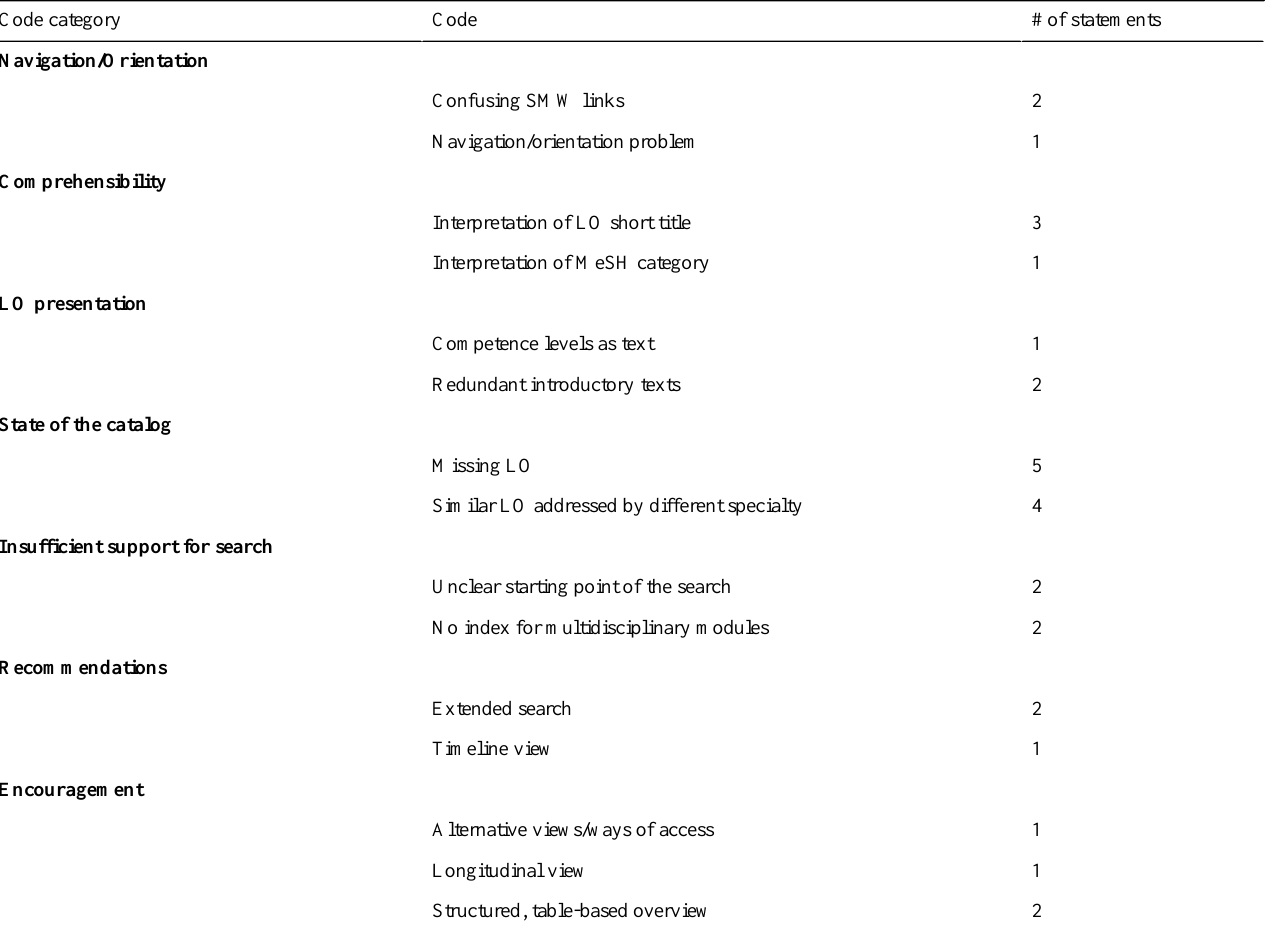
Table 2. Qualitative feedback: overview of the code categories derived from the